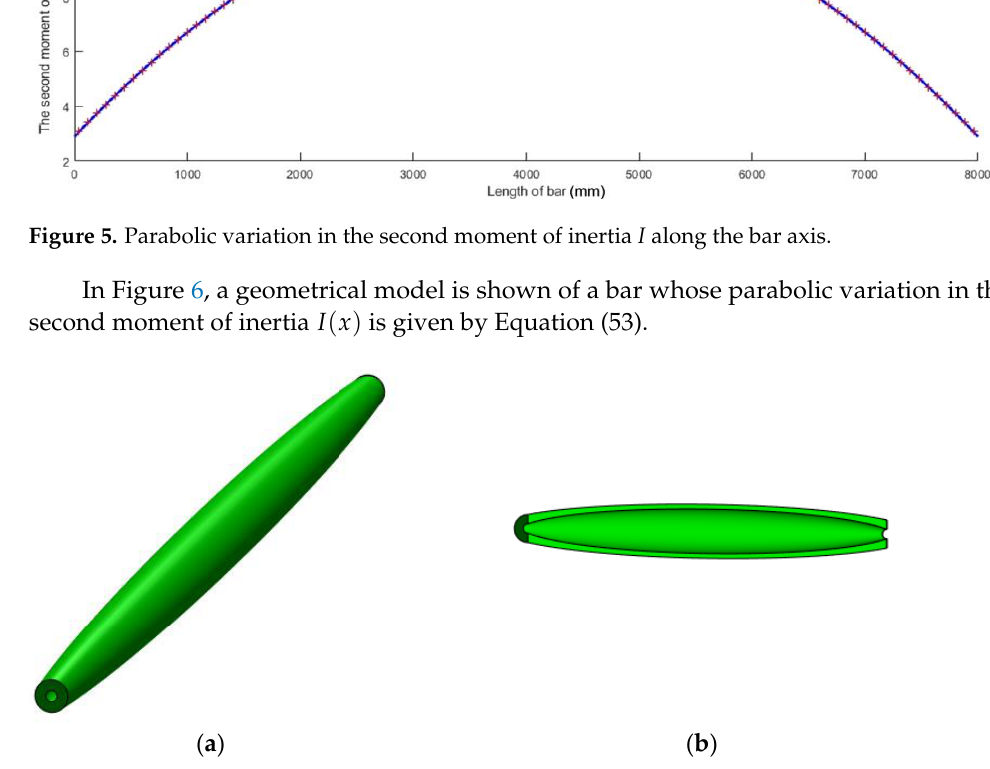
Figure 6. Geometrical model for a bar with parabolic variation in the second moment of inertia along the bar axis: ( a ) isometric view and ( b ) longitudinal section.